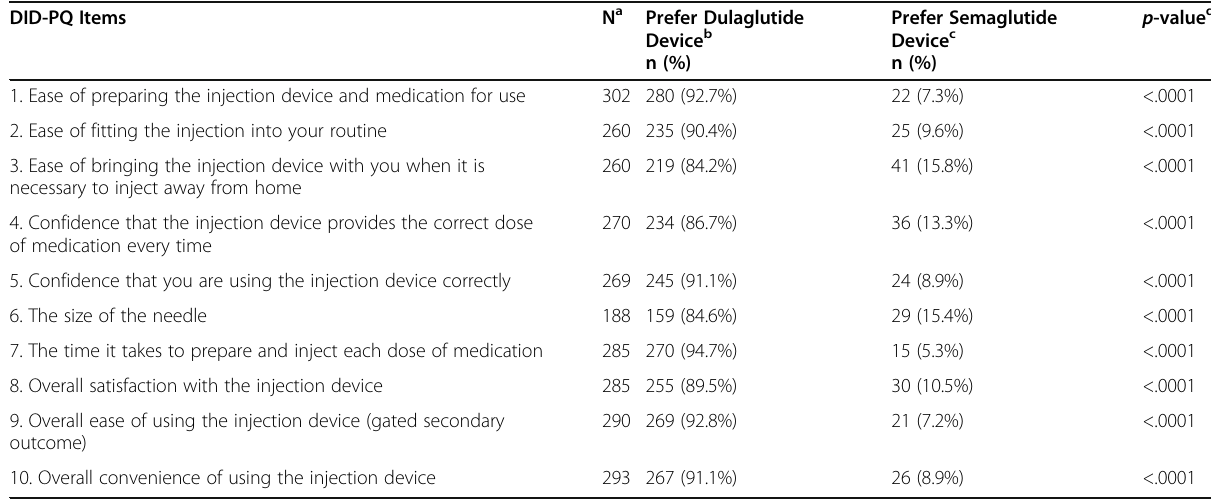
Table 3 Significance Testing for Difference in Preference between Devices on Each Item of the DID-PQ ( N = 310) DID-PQ